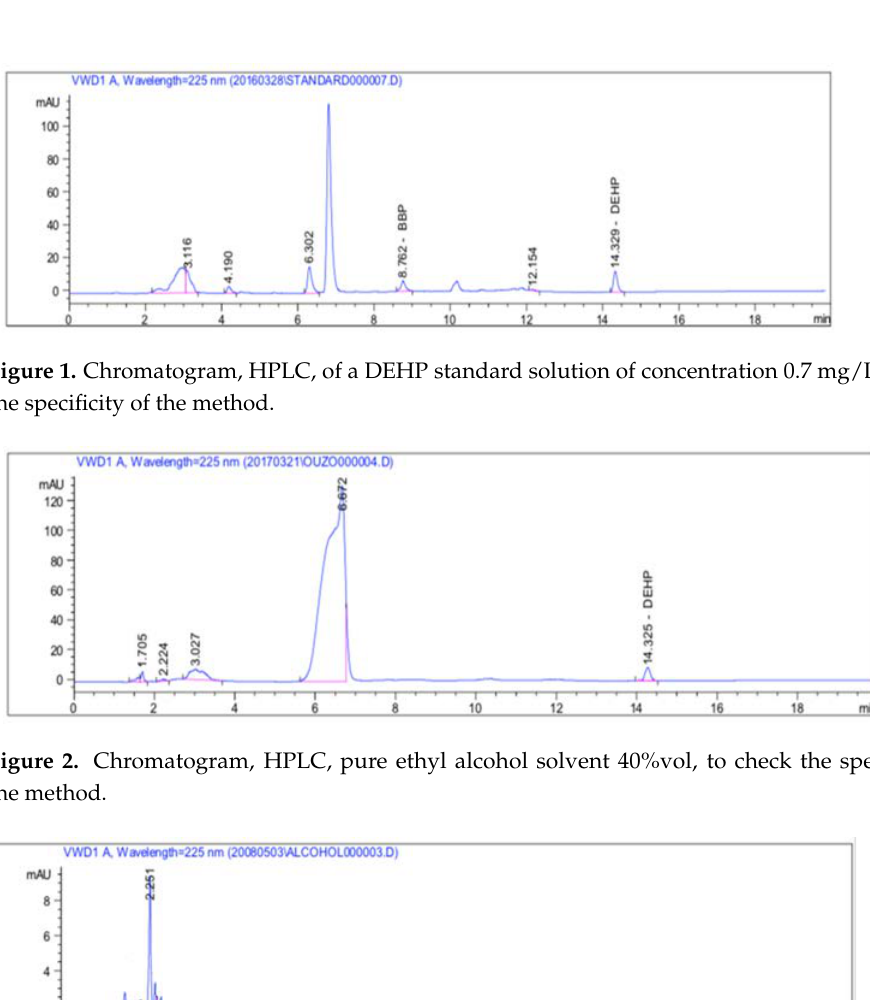
Figure 2. Chromatogram, HPLC, pure ethyl alcohol solvent 40%vol, to check the specificity of the method.